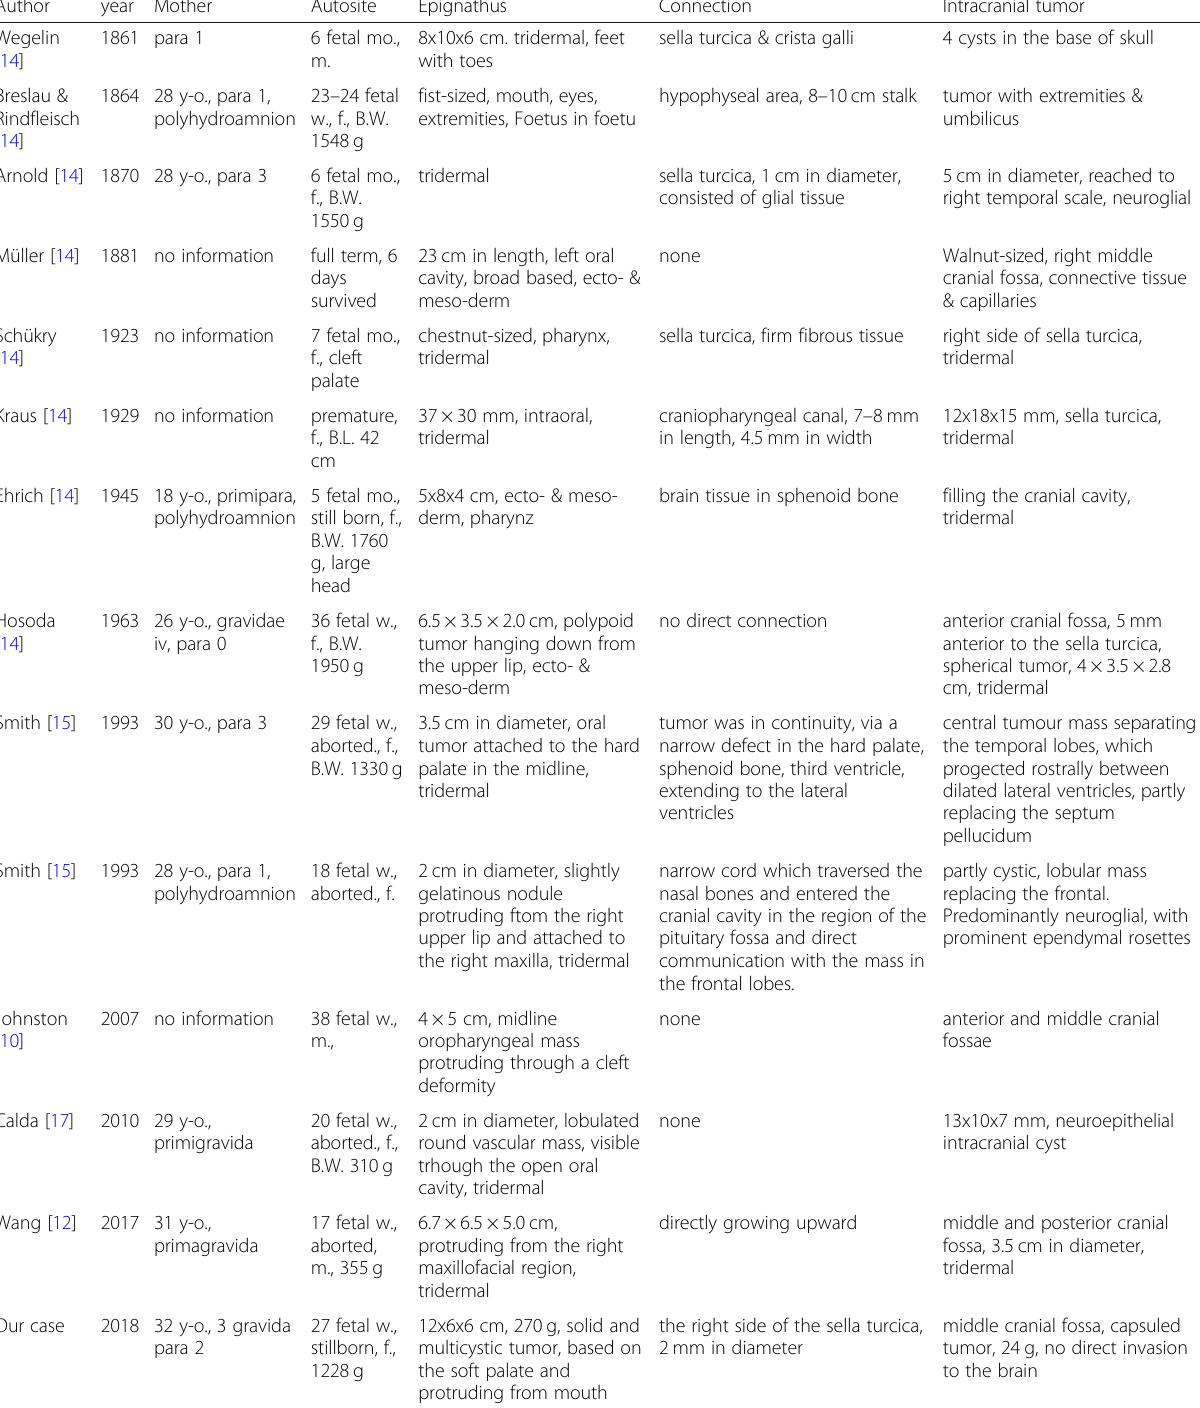
Table 3 Clinical and pathological summary of our case and 13 previously reported cases of epignathus with intracranial tumor. Earlier cases (1861 – 1963) were presented in the report by Y. Hosoda